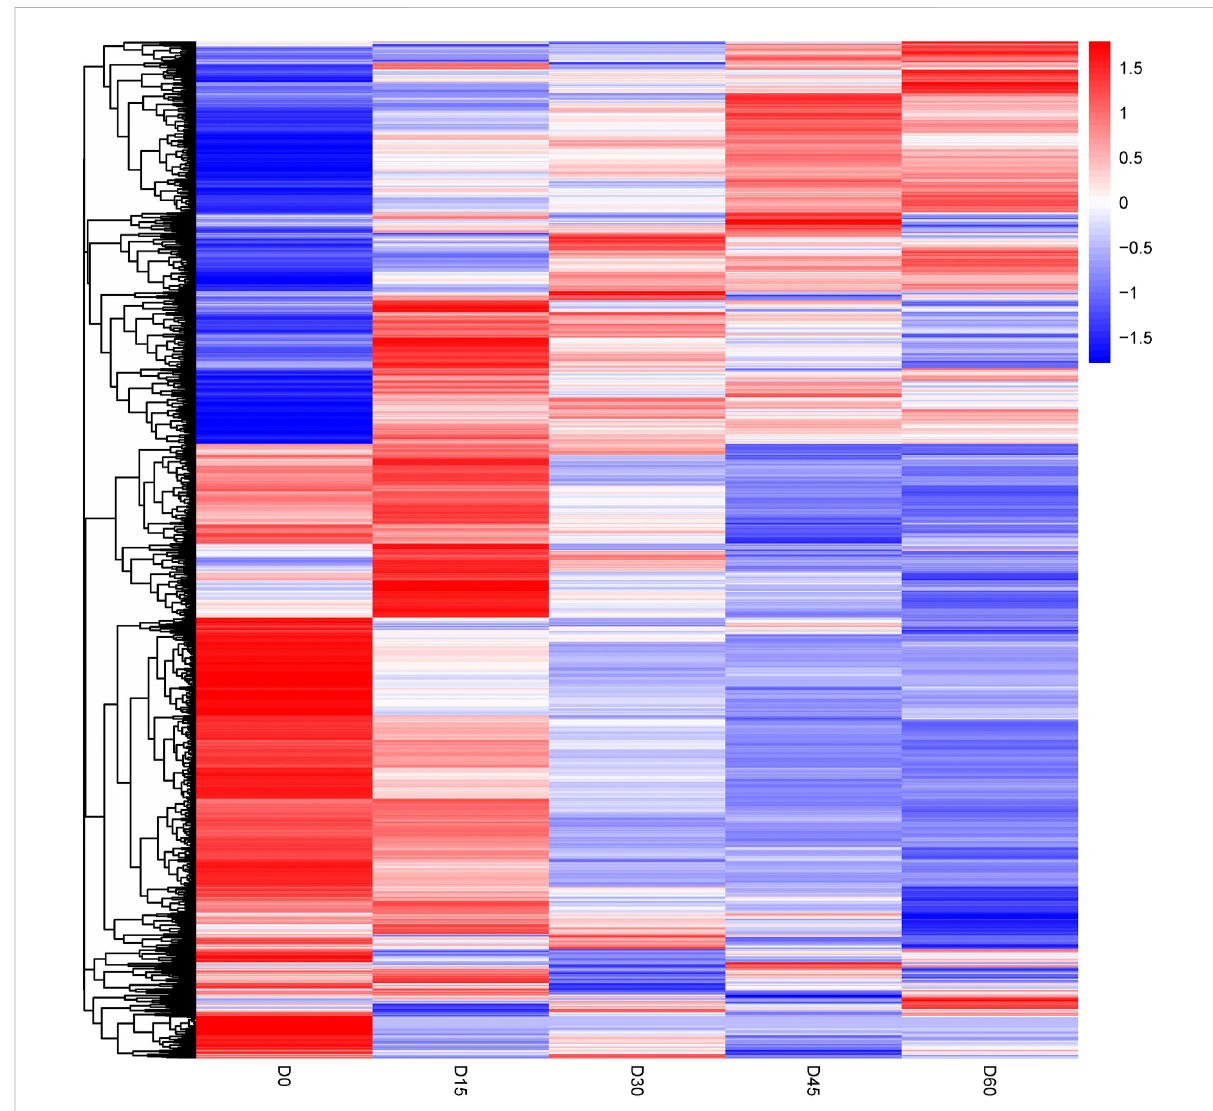
FIGURE 2 Heat map of differentially abundant proteins in rumen epithelium at the age of day 0, day 15, day 30, day 45 and day